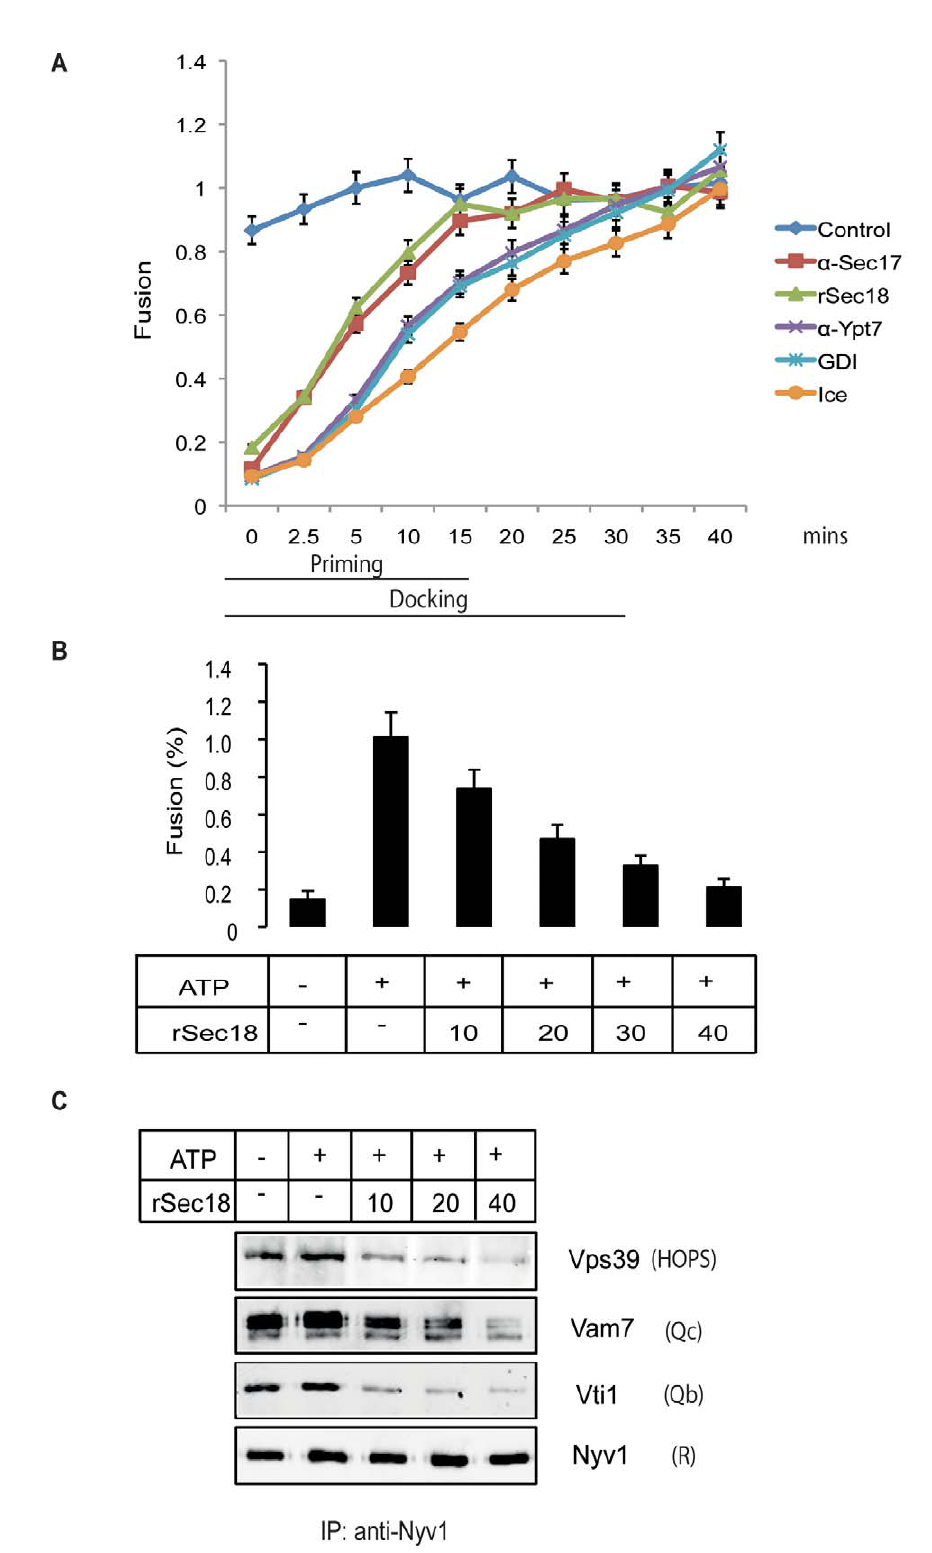
Figure 4. Excess rSec18 inhibition kinetically localizes to the priming reaction. (A) Kinetic analysis of rSec18 inhibition. Standard fusion reactions were started at 27 u C. At the indicated times, inhibitors or control buffer were added. The samples were left on ice for 5 min. Then, they were transferred to 27 u C or left on ice for the remainder of the 40 min reaction period. After 40 min, fusion activity was assayed. The following inhibitors were used: anti-Sec17 (3 m M), anti-Ypt7 (5 m M), and rSec18 (50 m g/ml). (B) Inhibition of vacuolar fusion by increasing amounts of rSec18 ( m g/ml) added to standard fusion reactions. After 60 min of incubation at 27 u C, vacuoles were assayed for fusion activity as described in experimental PLoS Biology |